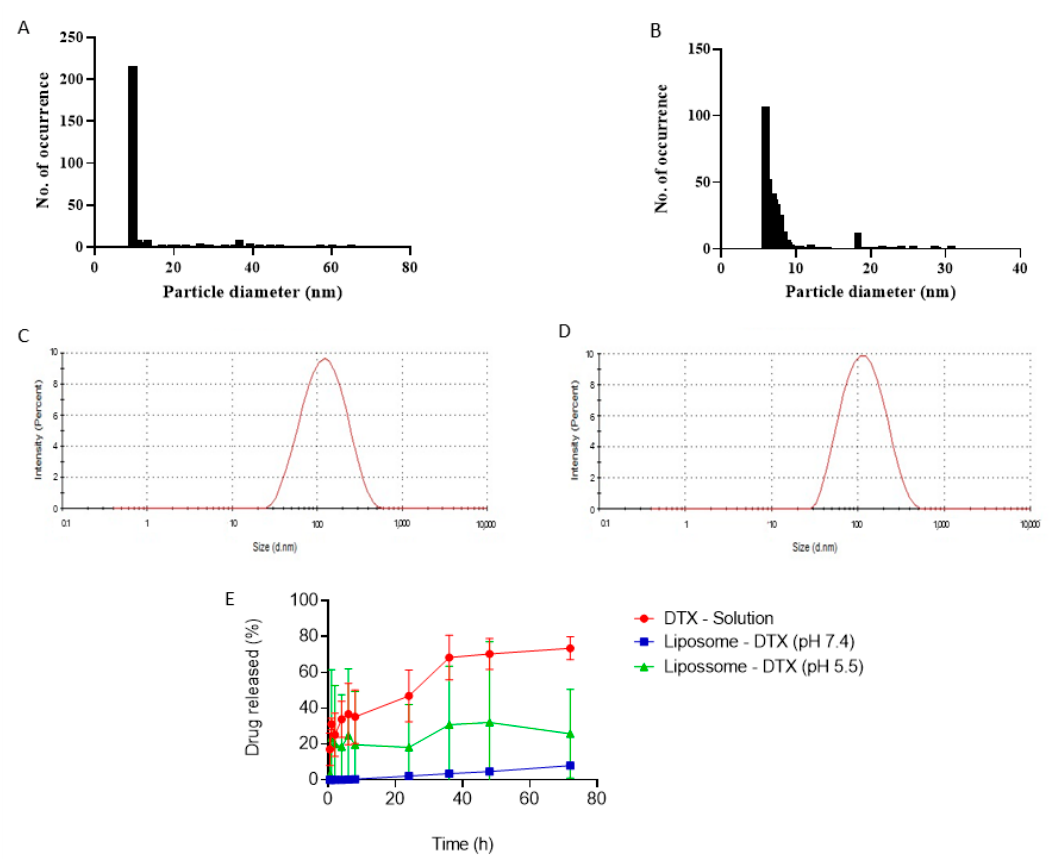
Figure 7. Particle size distribution: DTX liposome by MFA ( A ), DTX liposome by DLS ( C ), DTX immunoliposome by MFA ( B ), DTX immunoliposome by DLS ( D ), in vitro release study of DTX- loaded liposome and DTX solution using dialysis membrane ( E ).